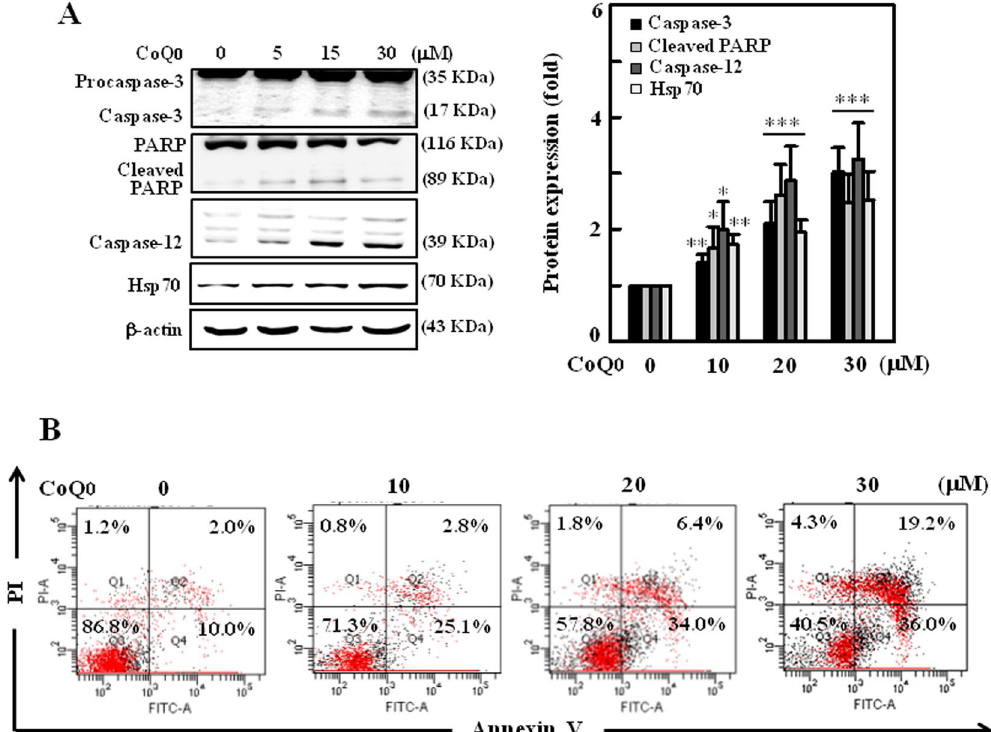
Figure 4. CoQ 0 induces apoptosis through mitochondrial and ER stress pathways in SKOV-3 cells. ( A ) Cells were treated with CoQ 0 (0–30 µ M) for 24 h, and apoptotic proteins involved in mitochondrial pathway (procaspse-3, caspase-3 and PARP) and ER stress pathway (caspase-12 and Hsp70) were estimated by Western blot. Changes in protein intensities were quantified by commercially available software, and presented as histogram. (B) Annexin-V-FITC and PI staining was used to identify the early/late apoptosis or necrosis of cells followed by CoQ 0 (0–30 µ M) treatment. Results from flow cytometry analysis in each quadrant (Q) are labeled and interpreted as follows: (Q1) PI positive, Annexin-V-FITC-negative stained cells/necrosis. (Q2) PI positive, Annexin-V-FITC-positive stained cells/late apoptosis. (Q3) cells negative for both PI and Annexin- V-FITC staining/normal live cells. (Q4) PI-negative, Annexin-V-FITC-positive stained cells/early apoptosis. Results expressed as mean ± SD of three independent assays (n = 3), and significant at * p < 0.05; ** p < 0.01; *** p < 0.001 compared with untreated control